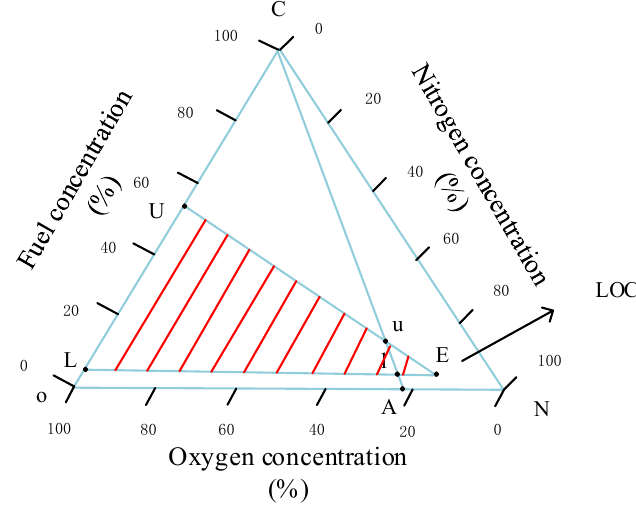
Figure 11. RP-3 fuel flammability diagram.